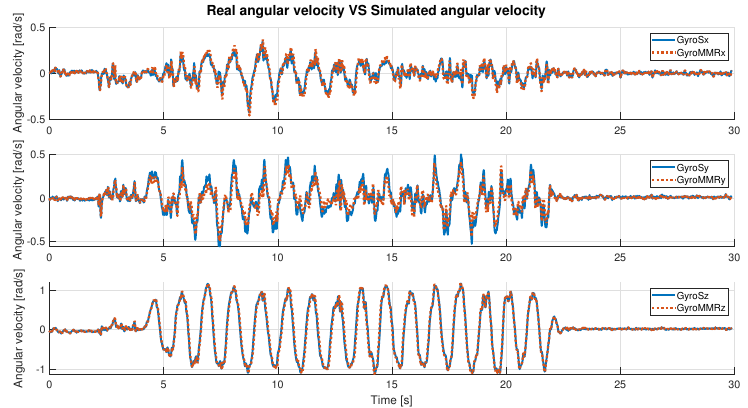
Figure 6. Real acceleration data vs. simulated acceleration data.